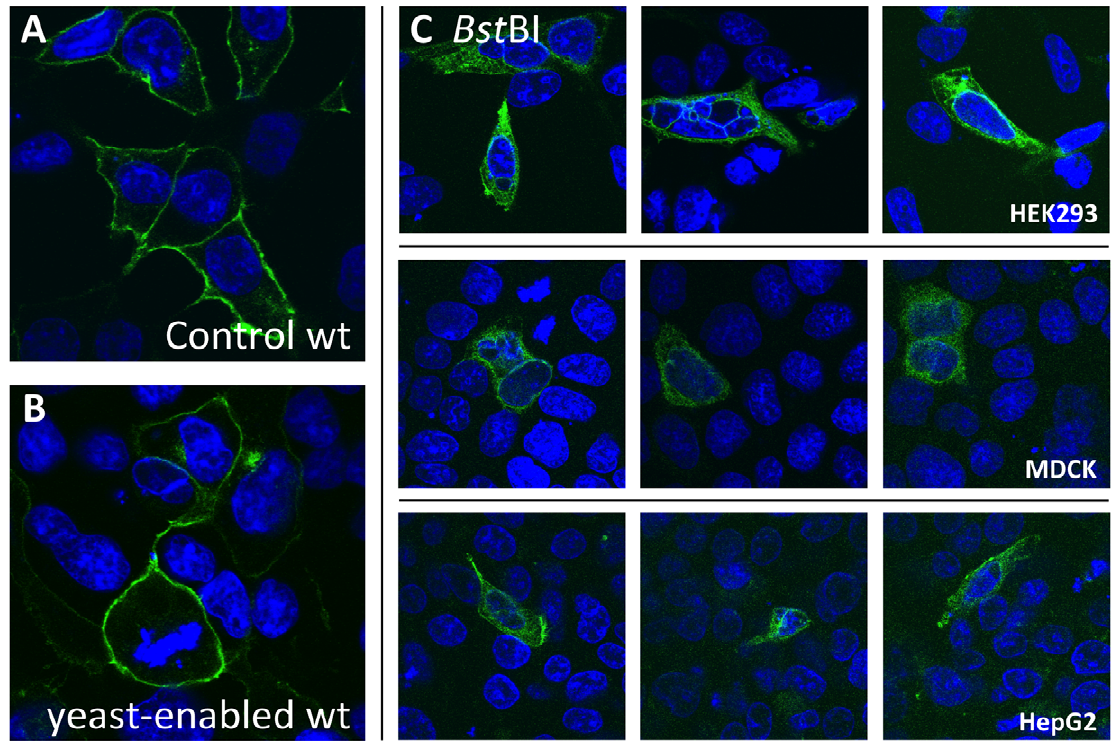
Figure 3. The yeast-maintainable BSEP expression plasmid is functionally indistinguishable from the non-yeast parental plasmid in mammalian cell culture. A, HEK293 cells were transfected with pEYFP-N1- BSEP . B, HEK293 cells were transfected with pEYFP-N1-OriLeu- BSEP . Equimolar amounts of both constructs showed comparable transfection efficiencies and expression levels (established by FACS analysis, see Figure S3). C, HEK293 (upper panel), MDCK (middle), and HepG2 cells (lower panel) were transfected with the Bst BI mutation in pEYFP-N1-OriLeu- BSEP that was introduced with the E. coli -free site-directed mutagenesis method. All cells were transfected with equimolar amounts of the respective constructs via Lipofectamine according to the manufacturer’s guidelines. After fixation, nuclei were stained with Hoechst 34580 (blue), and the fluorescence (green) of the YFP tag in the BSEP fusion protein was observed.